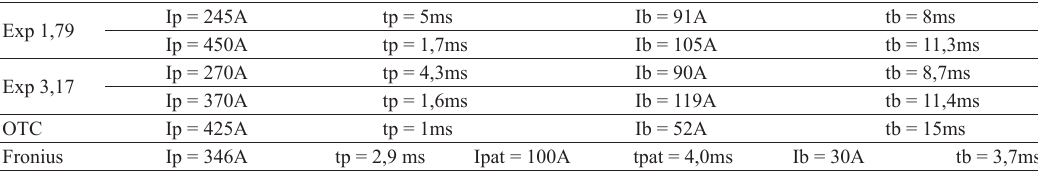
Table 1. Parameters for different pulsed wave.